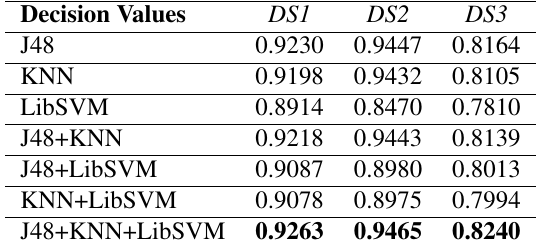
Table 6. The results of decision values with average weight val- ues { 1/3, 1/3, 1/3 }